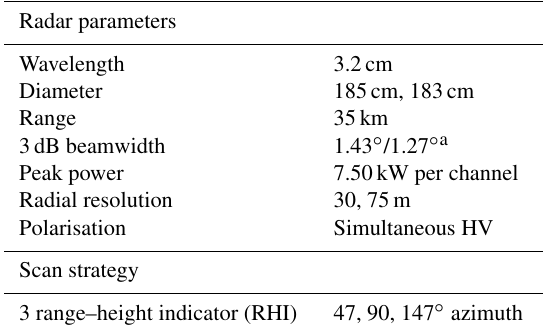
Table 1. Characteristics of the MXPol radar and scanning strategy during the Valais